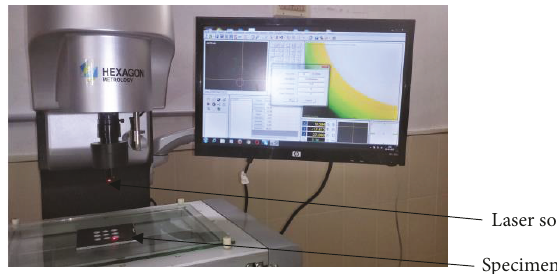
Figure 5: Delamination measurement at the entry and